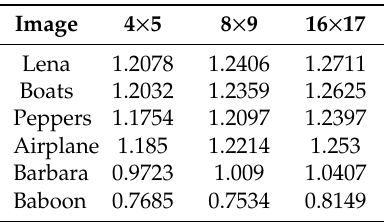
Table 2. Pure embedding capacity under di ff erent block sizes (bpp).